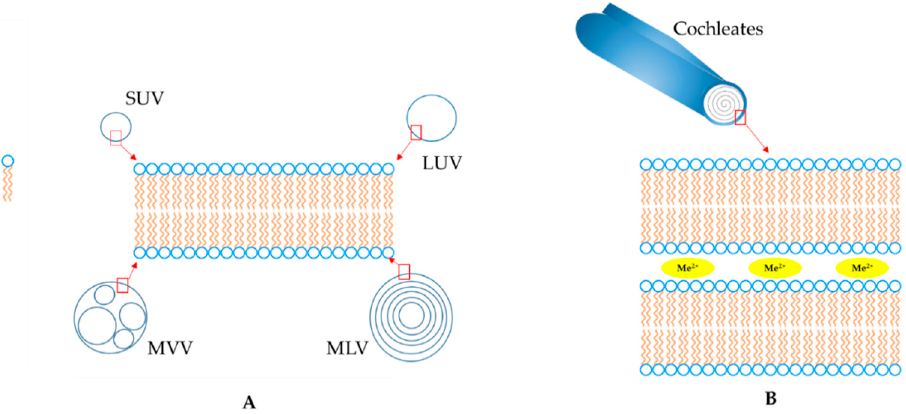
Figure 1. Schematic representation of the structures of liposomes ( A ) and nanocochleates ( B